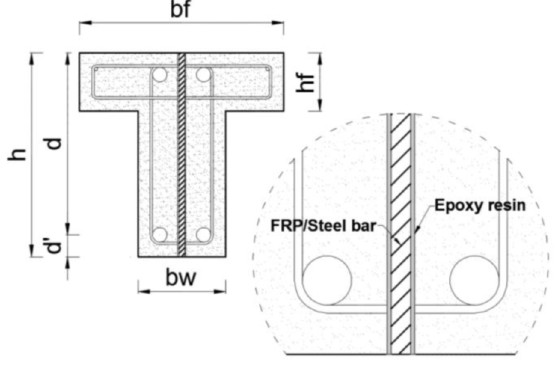
Figure 3. Schematic of the deep reinforcement embedment technique for T-beams [58].